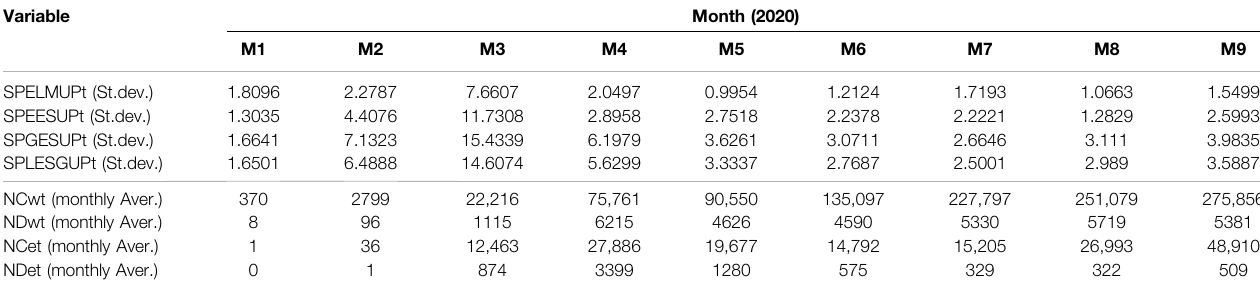
TABLE 10 | Monthly analysis of selected fi nancial market indexes and COVID-19-related variables. Variable